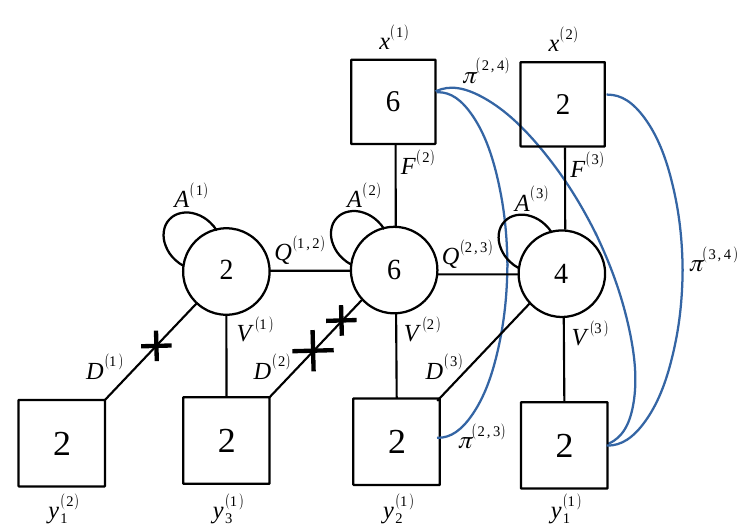
Figure 25 . The quiver diagram representation of E [2 (cid:13) 22 , denoted by crosses with two di(cid:11)erent sizes, (cid:13)ip Tr 1 D (1)